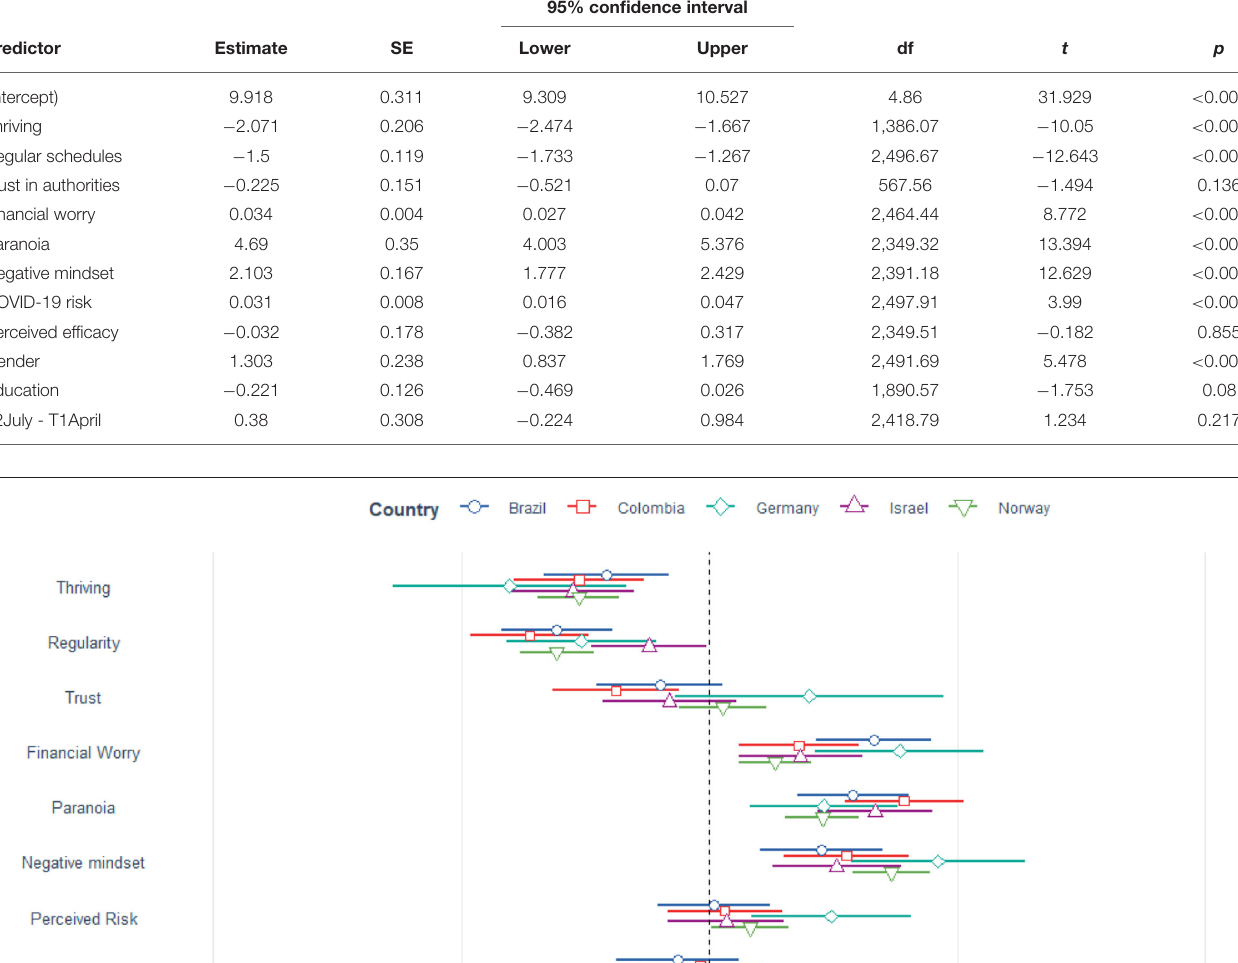
TABLE 2 | Fixed effects parameter estimates for general distress.